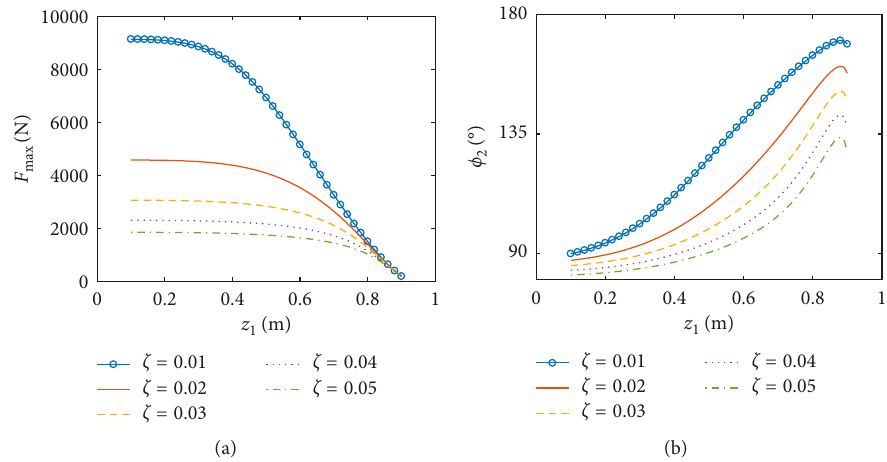
Figure 13: The amplitudes and the phases of the resultant force versus the position of the flexible baffle for R amplitude of the resultant force, (b) the phase of the resultant force.